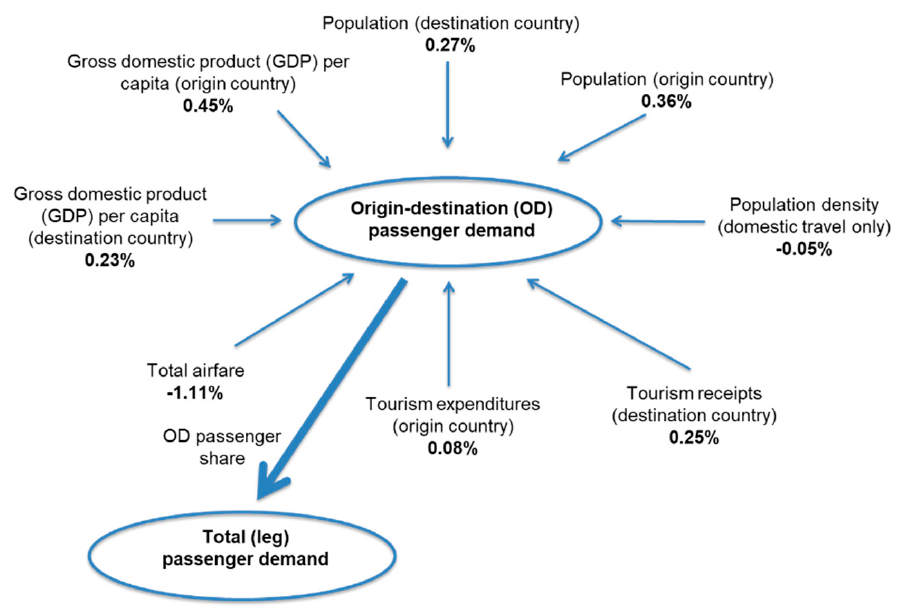
Figure 4. Elasticities of air passenger demand. Reprinted from Ref. [7].